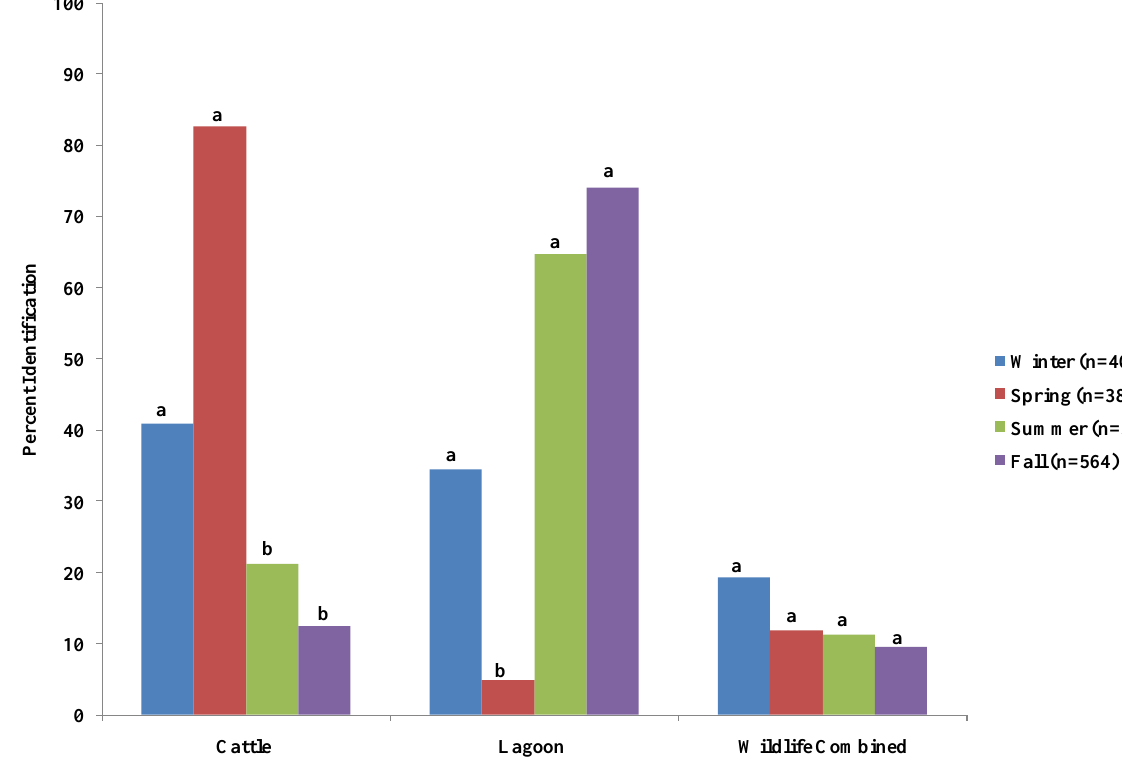
Figure 7. Seasonal characteristics for host source identification of E. coli isolates that occurred above the 9% minimum detectable percentage (MDP) from three Six Runs Creek sampling sites adjacent to waste application field two